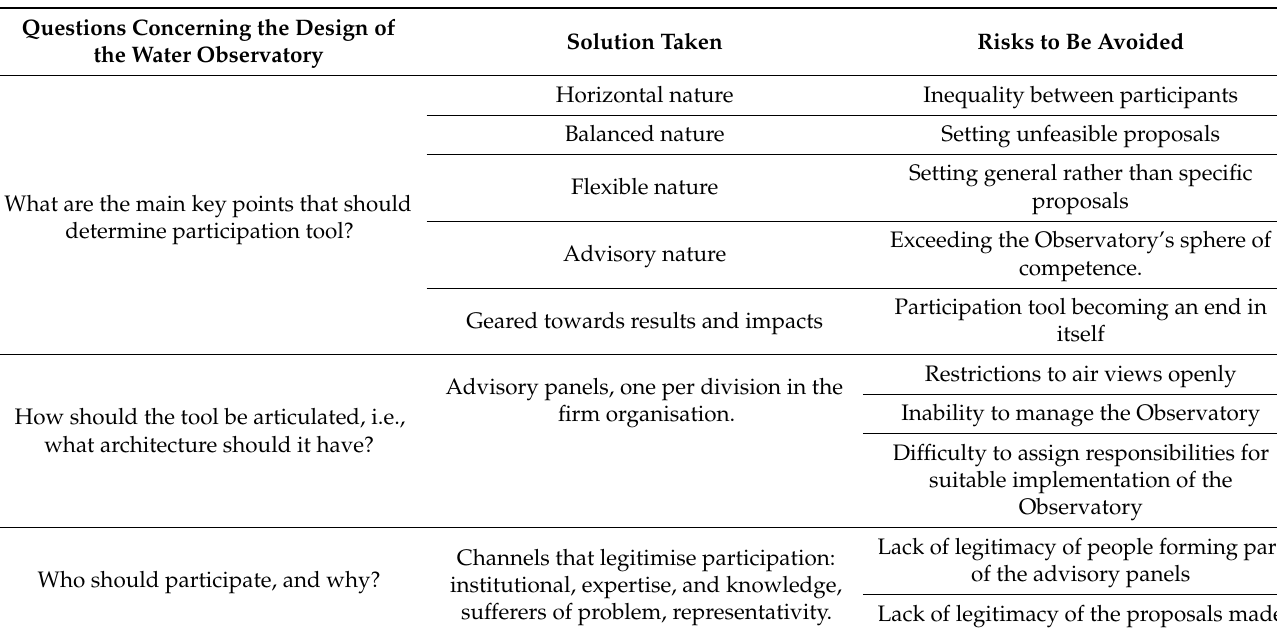
Table 2. Summary of the Water Observatory design through pre-mortem analysis: risks to be avoided and solutions